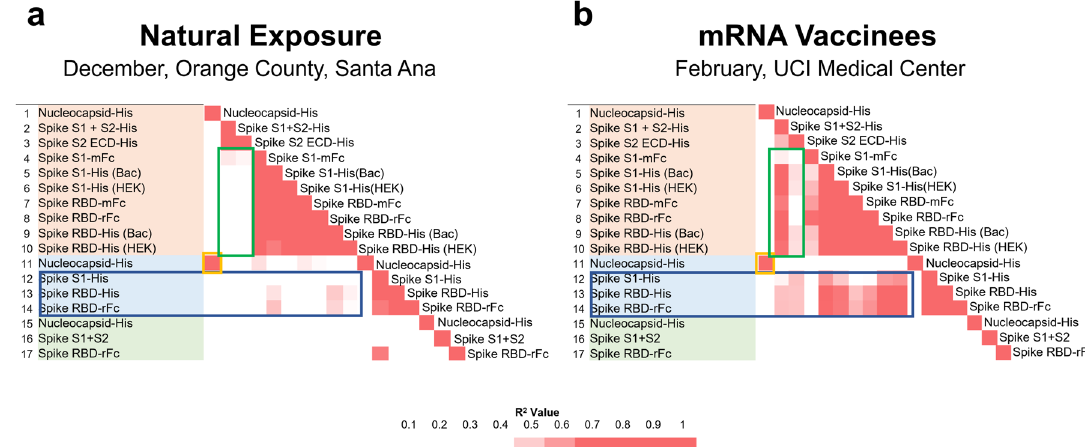
Fig. 5 COVAM pairwise correlation matrices. Correlation matrices with all pairwise comparisons between all antigens on the COVAM array were generated. The heatmaps represent a color scale of the r-squared of each pairwise comparison. On a is shown the correlation matrix for the Orange County group (actOC Natural exposure) and in b is shown the UCIMC vaccinated group. The mRNA vaccine induces cross reactive antibodies against SARS S1 and the RBDs ( b , Blue Box) and natural exposure does not ( a ) Similarly, vaccine induced antibodies against full length spike cross-react with SARS-CoV-2 RBD ( b , Green Box) and the natural exposure does not ( a ).